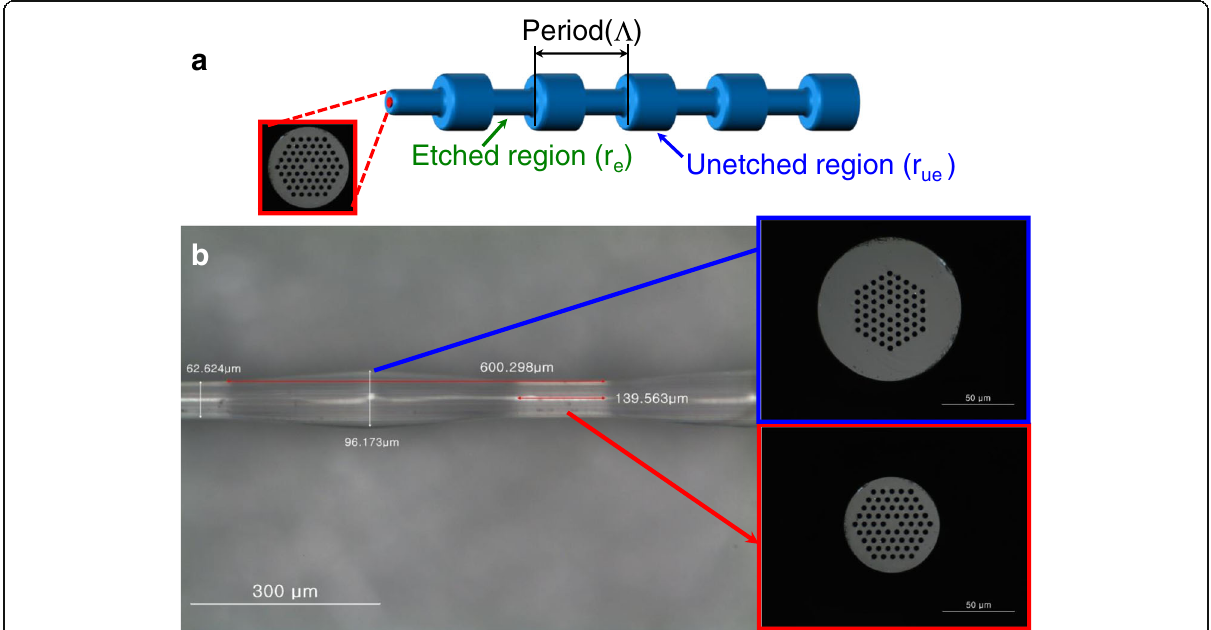
Fig. 2 a Structure of the proposed PCF-based LPG. b Photograph of the fabricated PCF-based LPG measured by using an optical